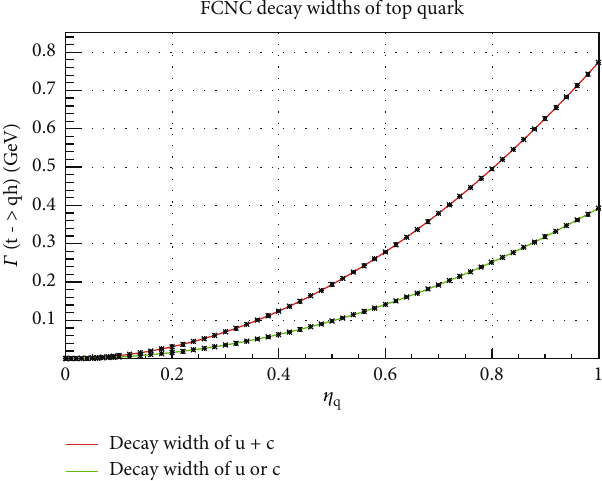
Figure 1: The FCNC decay width of top quark according to two scenarios, for u + c case top quark can decay into both, otherwise decays into only one of